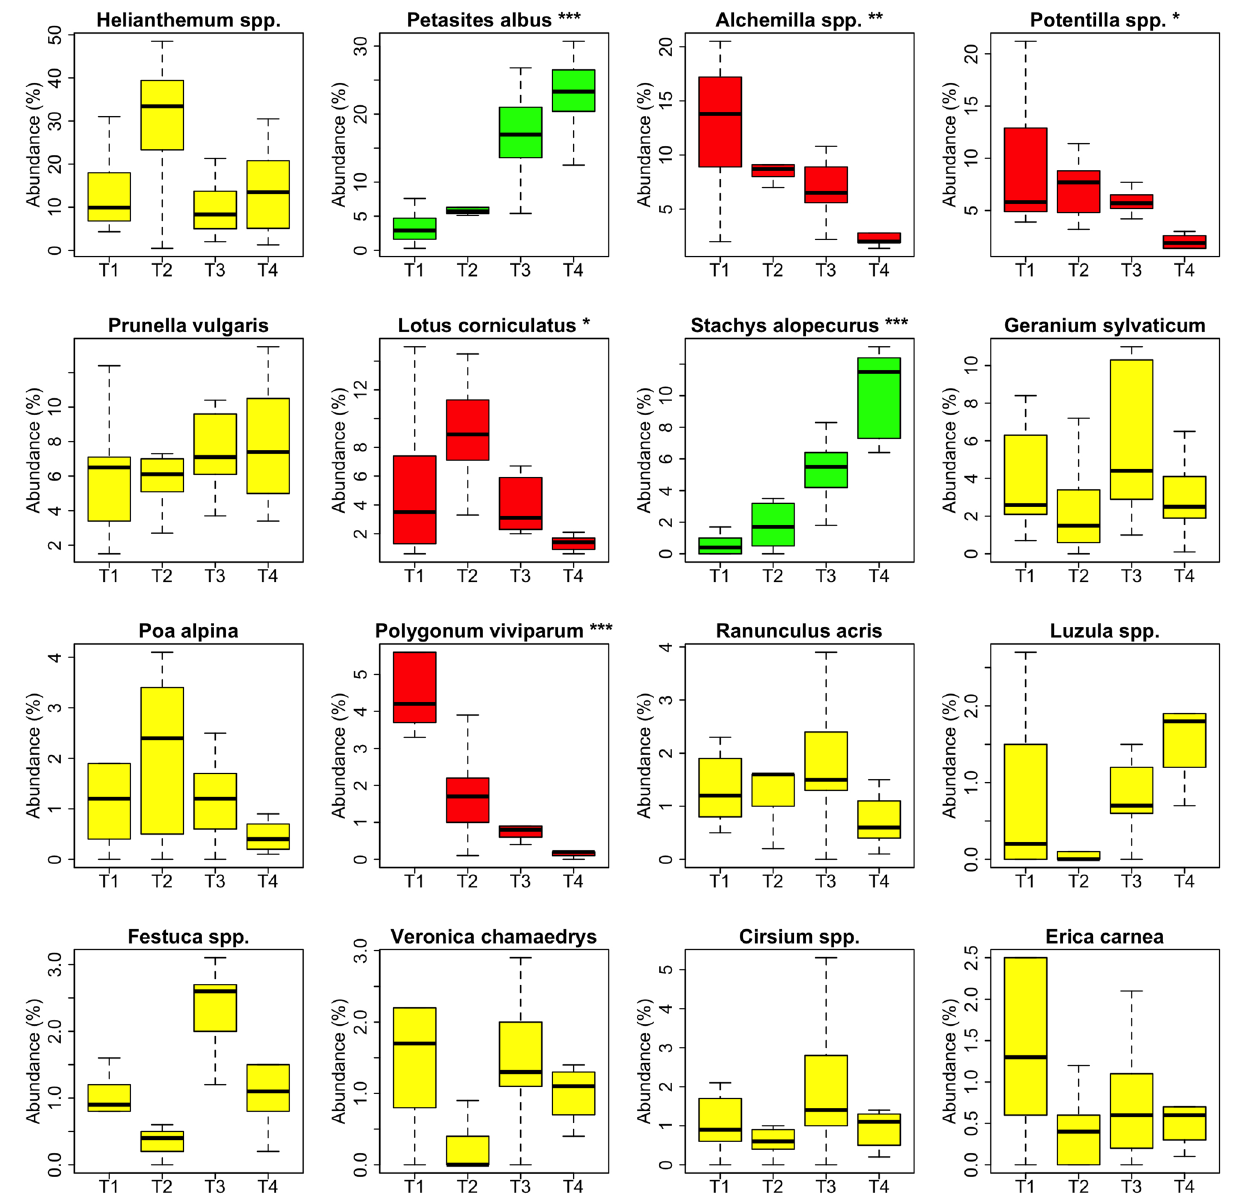
Figure 2. Variation of the relative abundance (% of total abundance) of the 16 plant genera/species identified in faecal samples with a relative abundance > 1% in relation with collection time (T1, T2, T3 and T4). Plant taxa are ordered from left to right and top to bottom according to decreasing average relative abundance. The significance of the effect of collection time in the linear mixed regression models analysing relative abundances (standardized with total sum scaling (TSS) normalisation followed by square route transformation) is indicated as *** P < 0.001; ** P < 0.01; * P < 0.05. Boxplots in yellow indicate non-significant temporal trends, boxplots in green indicate a pattern of increase with collection time, boxplots in red indicate a pattern of